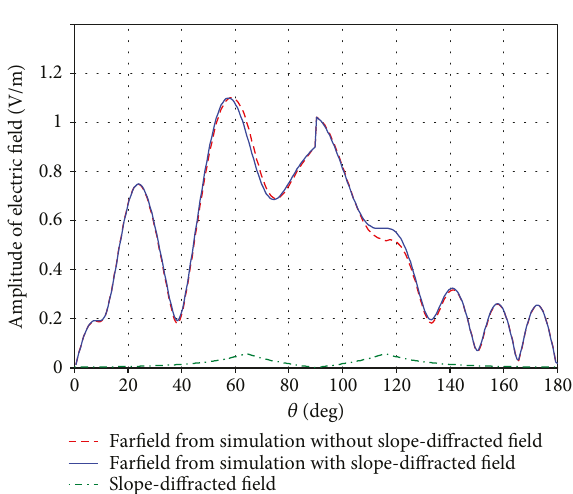
Figure 3: Total fi eld in the ϕ =5 ° plane with w =4 λ and h =1 λ , at 4